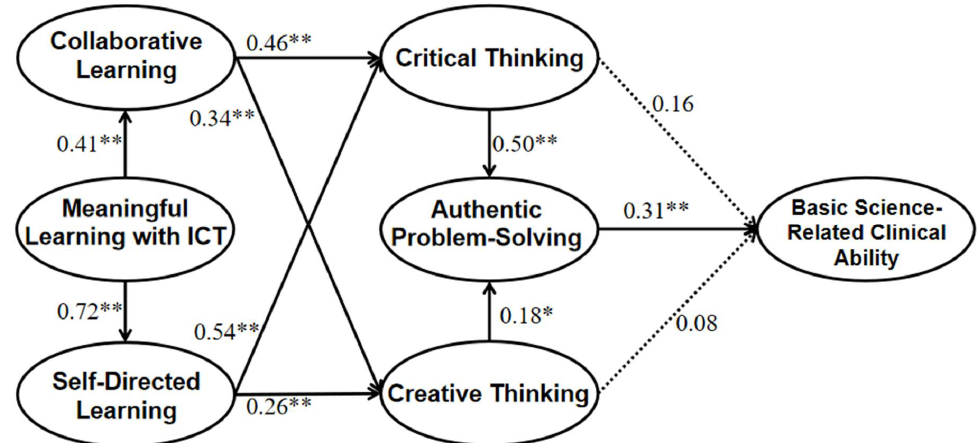
Figure 2. Path analysis with structural equation model on surveying medical students’ 21st century online learning patterns.Standardized coefficients for each path are presented in the figure. Dashed lines indicate non-significant paths. *p < 0.05; **p < 0.01; ***p < 0.001. N = 364.